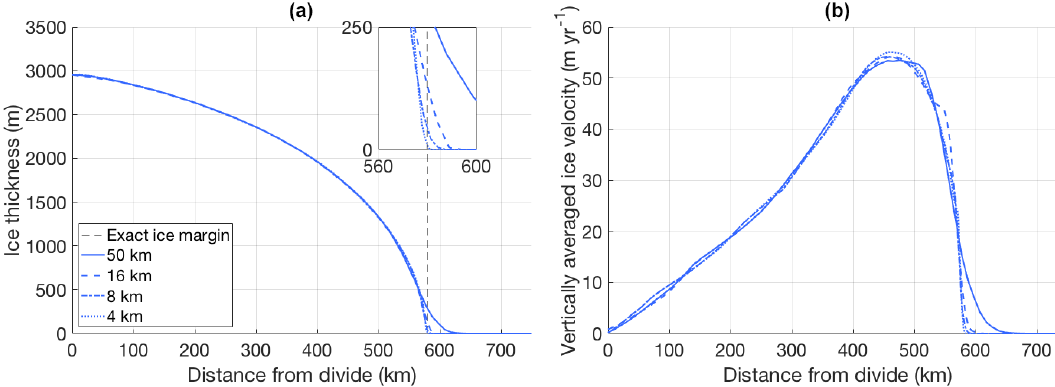
Figure 4. (a) Ice thickness and (b) vertically averaged ice velocity of a radial transect of the ice sheet in experiment I, simulated by UFEMISM at 50, 16, 8, and 4km ice-margin resolutions. The vertical dashed line in (a) denotes the analytical ice margin.